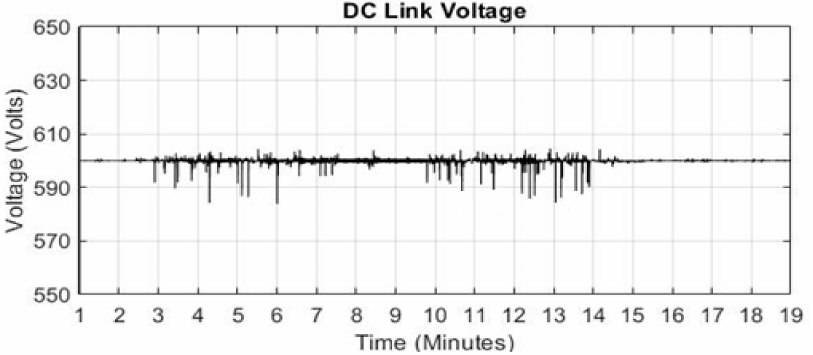
Figure 13. DC Link voltage for Load Profile 1.